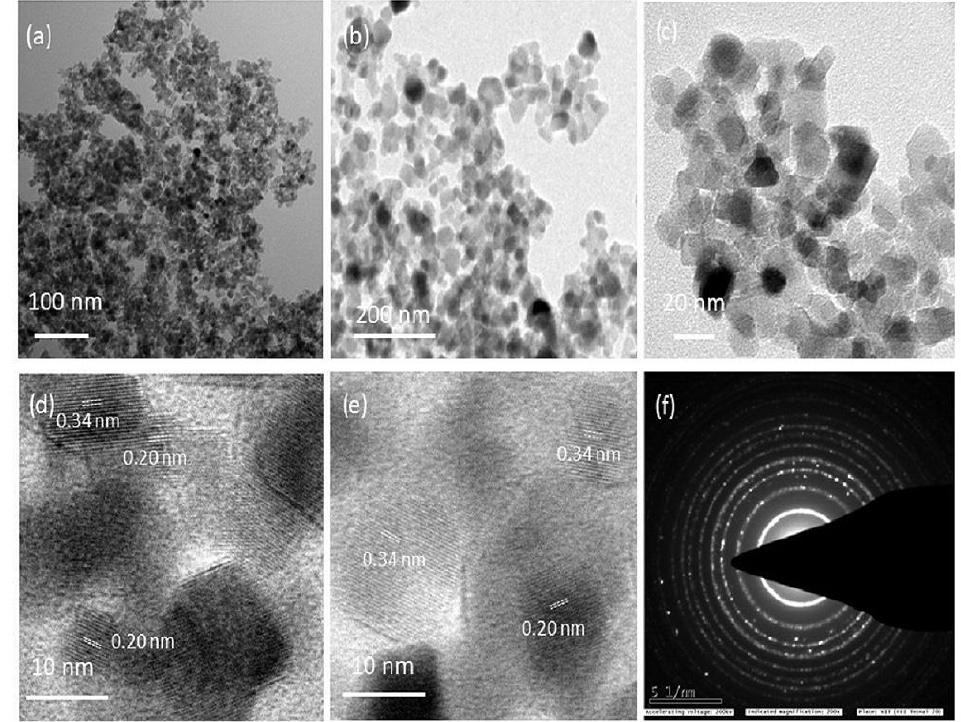
Figure 4. 7.5Ni/m-TiO 2 catalyst ( a ) TEM image, ( b – e ) HRTEM images, ( f ) SAED pattern. The reducibility of the m-TiO 2 and Ni-doped m-TiO 2 was investigated through H 2 - TPR measurements using 10% H 2 /Ar (Figure 5a). The pure m-TiO 2 showed a broad and low intensity TPR peak obtained in the temperature range of 430–670 ◦ C [38]. A distinct